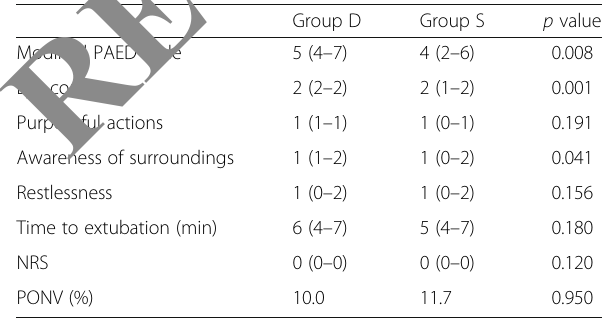
Table 3 Primary and secondary outcomes in the two groups Group D Group S p value Modified PAED